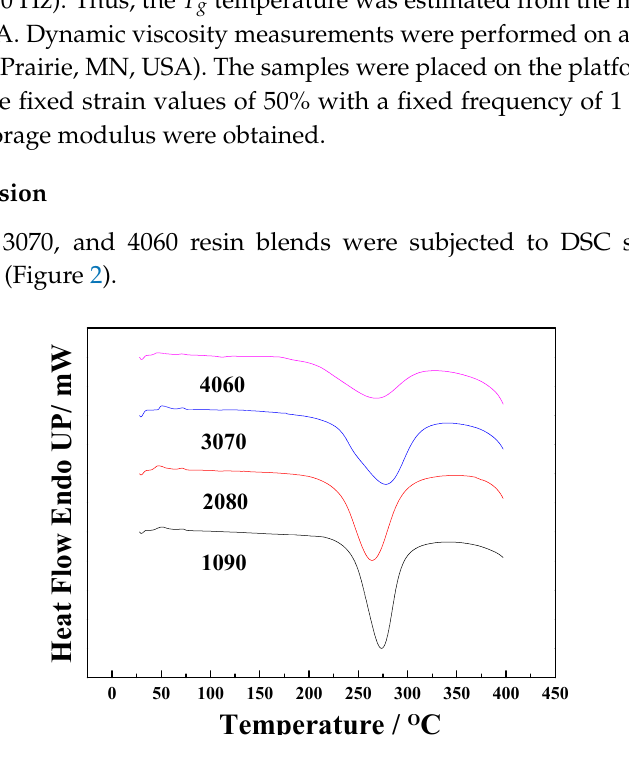
Figure 2. Differential scanning calorimetry (DSC) scanning diagram of 1090, 2080, 3070, and 4060 blend resins.